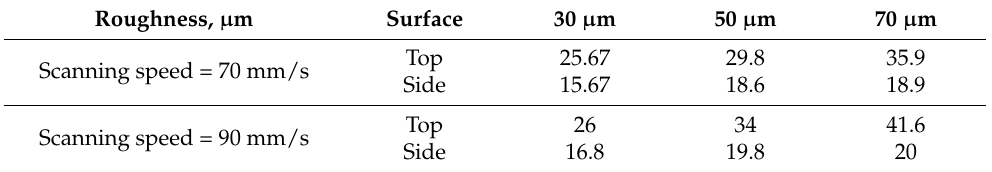
Table 4. Surface roughness (Ra) at different layer thicknesses and scanning speeds